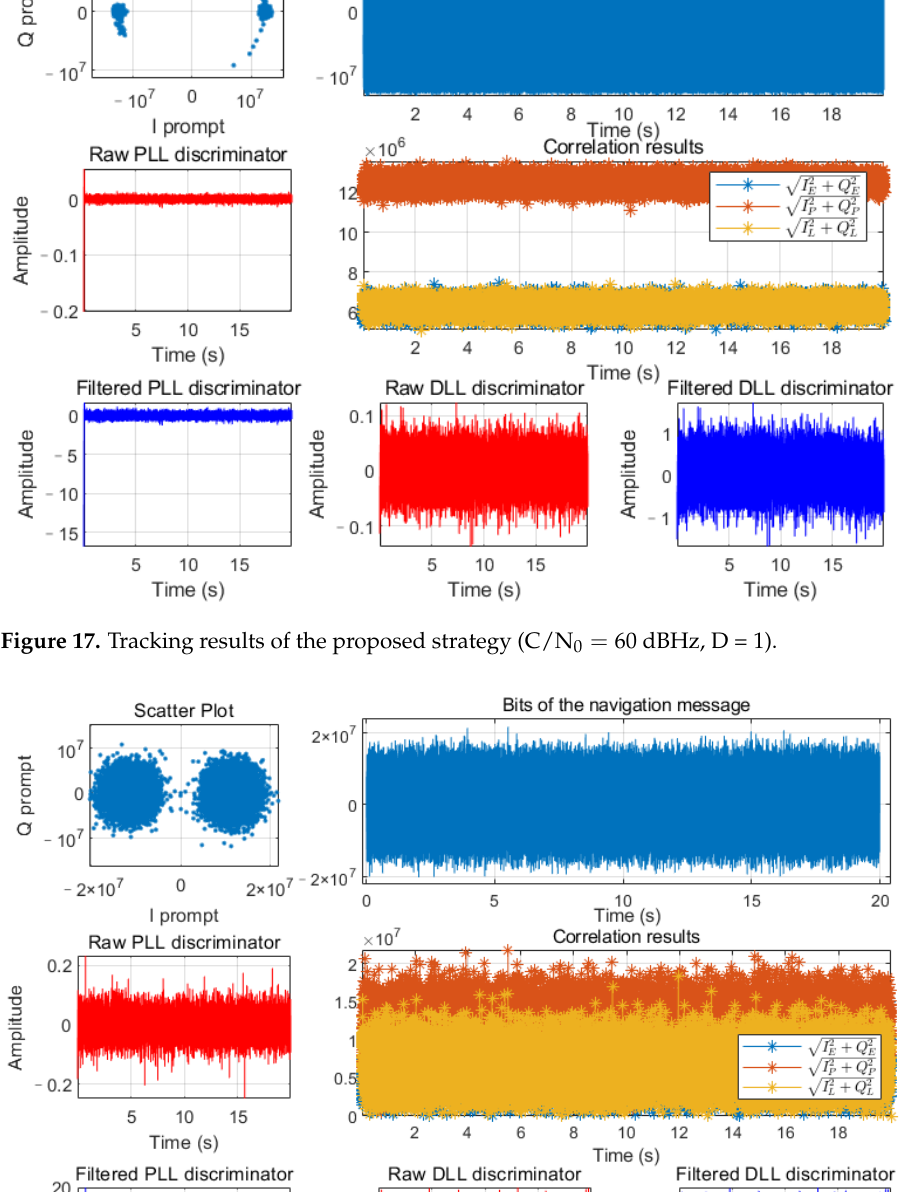
Figure 18. Tracking results of the proposed strategy ( C/N 0 = 40 dBHz , D = 1).